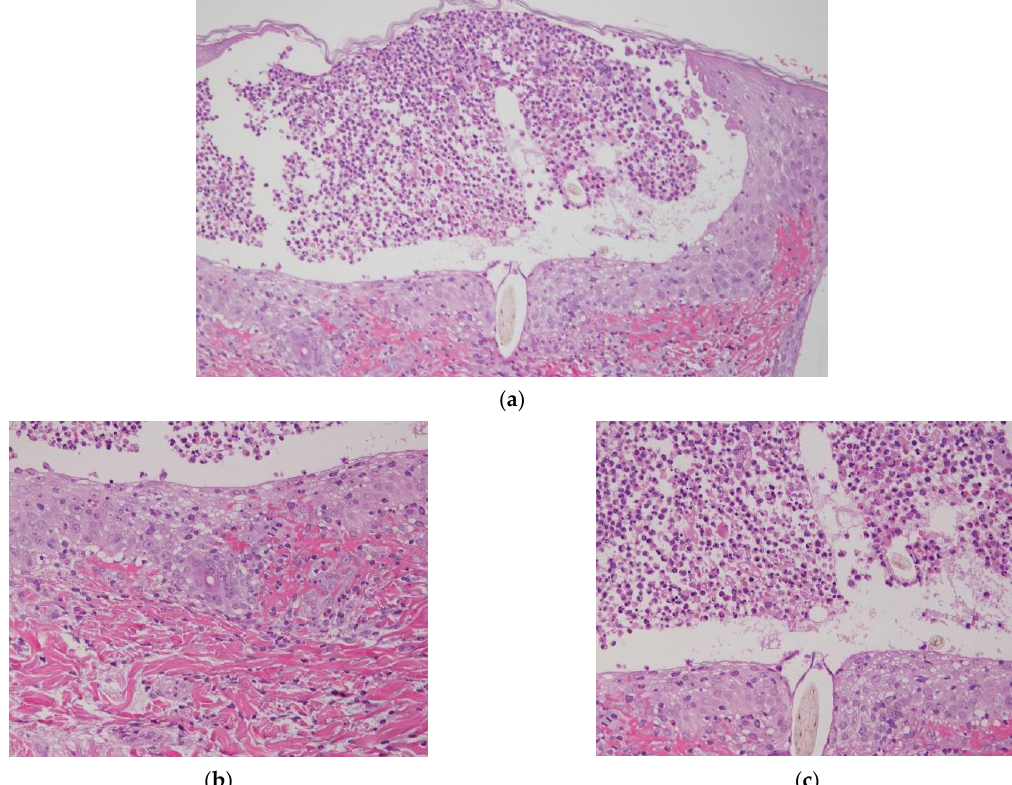
Figure 3. Hematoxylin and eosin staining. ( a ) A skin biopsy revealed pustules beneath the stratum corneum, which coincided with the epidermal opening of hair follicles. Original magnification ×100. ( b ) A small amount of inflammatory cell infiltration, such as eosinophils and lymphocytes, was also seen around the hair follicles in the dermis, and between the dermal collagen fibers. Original magnification ×200. ( c ) The pustules contained eosinophils, neutrophils, and hairs, suggesting the destruction of the hair follicles. Original magnification ×200.